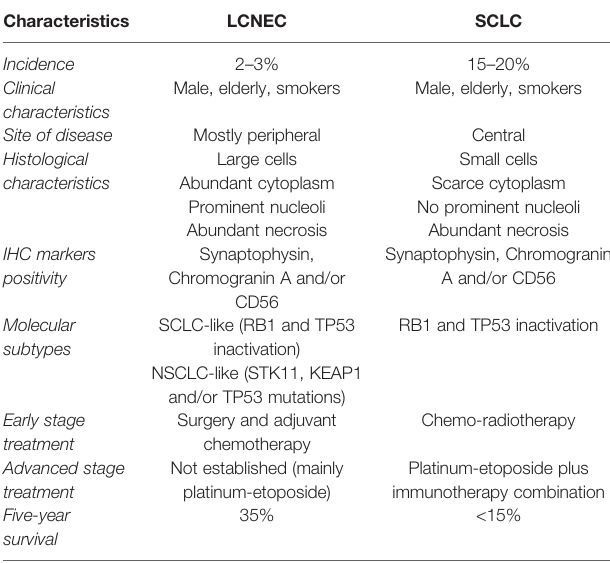
TABLE 1 | Differences between LCNEC and